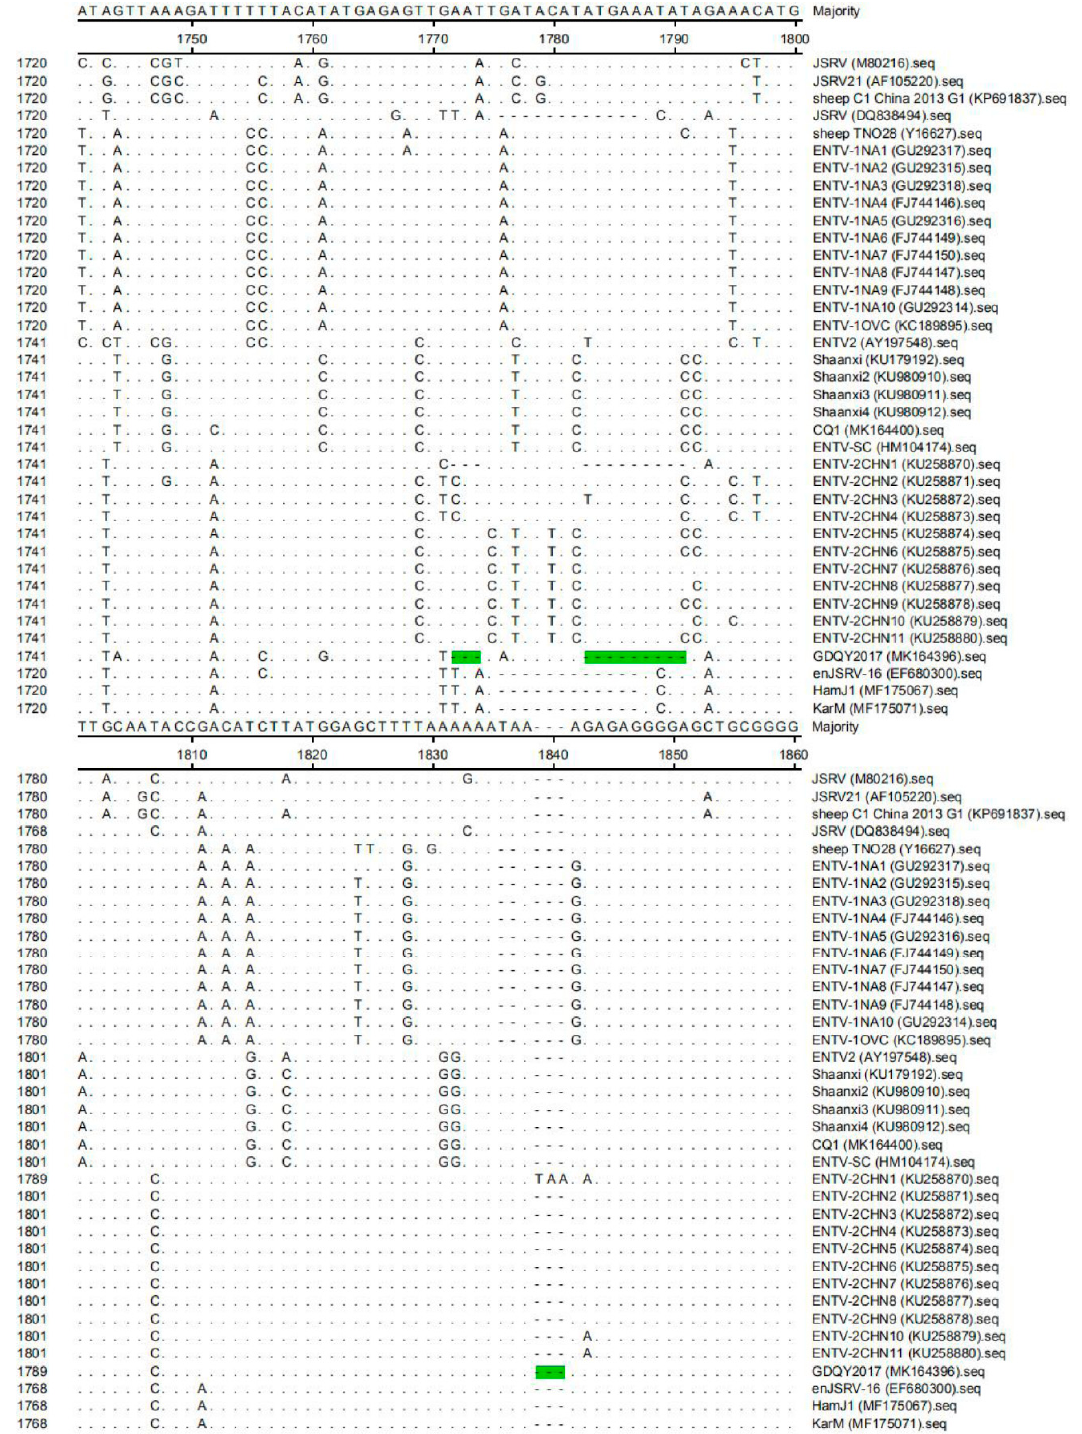
Figure 4. Multiple sequence alignment results of the env gene of ENTV-2 with ENTV-1, JSRV, and enJSRV. The nucleotide deletion sites in the env gene of GDQY2017 were marked with green color. Moreover, compared to ENTV-2CHN1, GDQY2017 had an additional three-nucleotide deletion (marked with green color) in position 1839–1841 of the env gene.